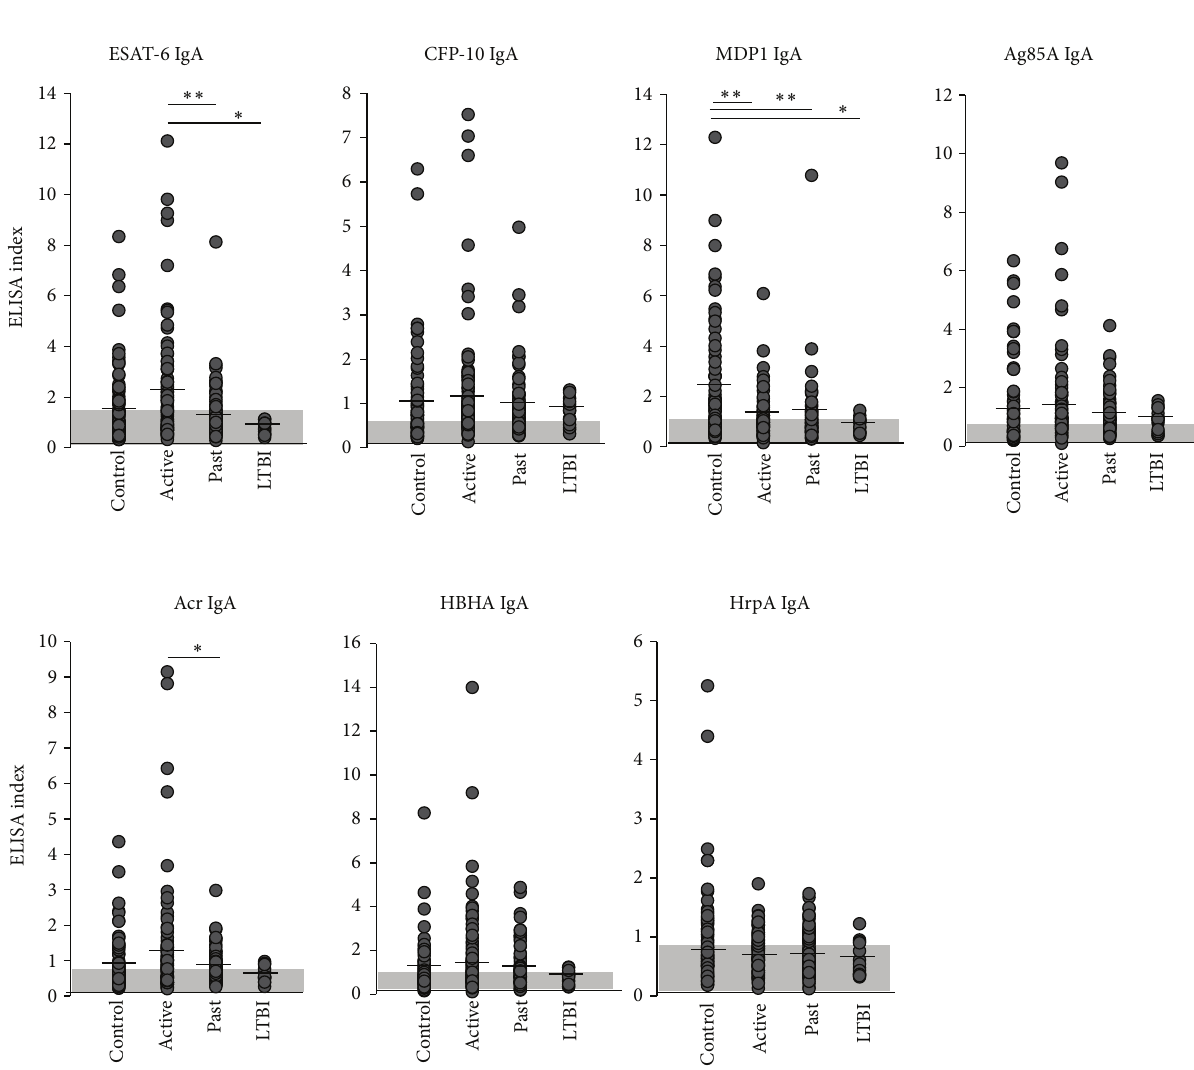
Figure 2: IgA responses to Mtb antigens. The levels of serum IgA against 7 antigens (ESAT-6, CFP-10, MDP1, Ag85A, Acr, HBHA, and HrpA) in active disease (labeled as “Active”), past disease (“Past”), latent TB infection (“LTBI”), and controls (“Control”) were analyzed by ELISA. Data shown are the average of triplicate experiments. Shaded areas: areas under cut-off values, vertical lines: mean values, ∗ 𝑃 < 0.05 , ∗∗ 𝑃 < 0.01